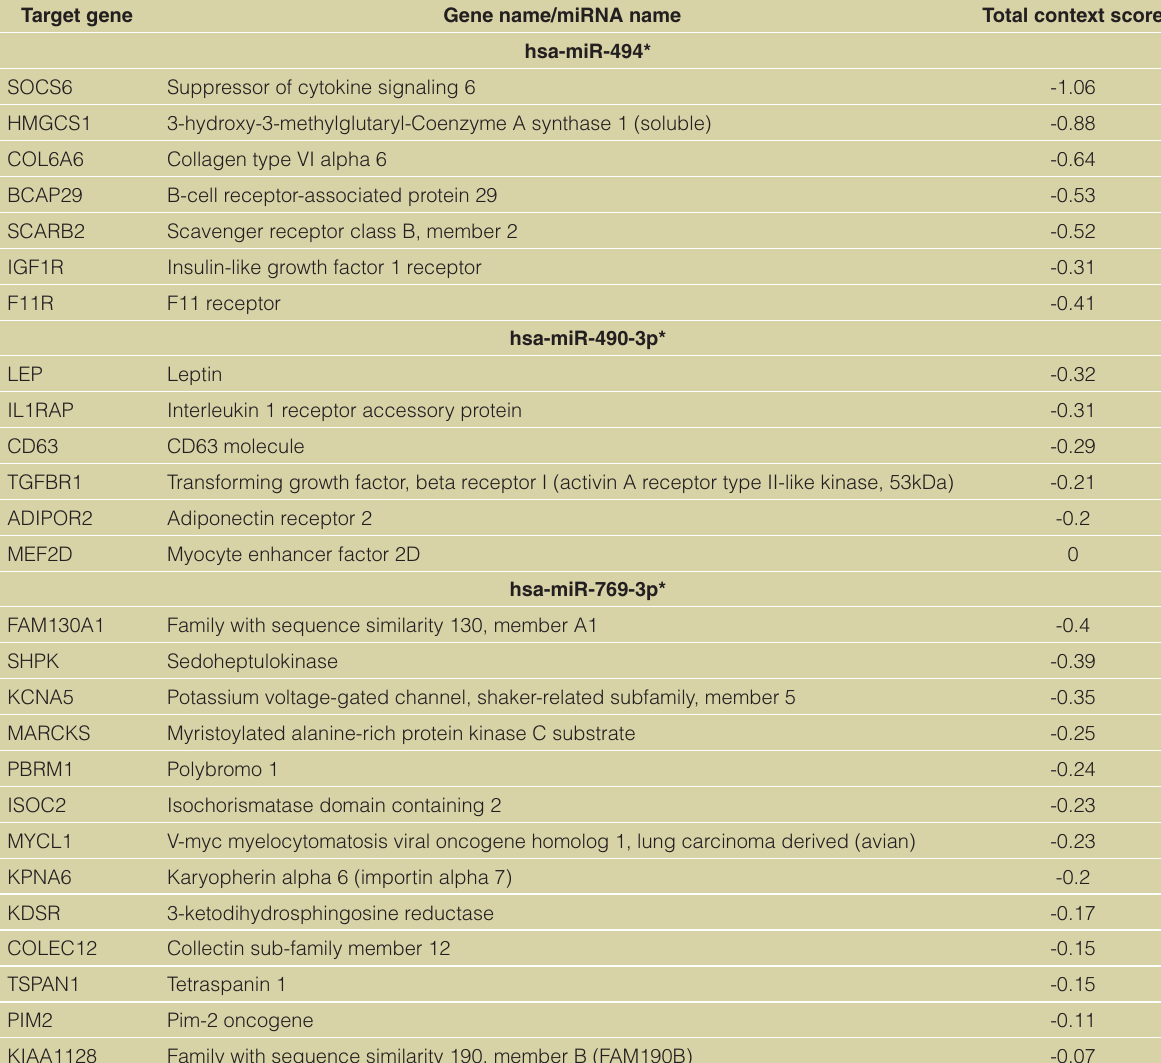
Table 5. MiRNA predictions for target genes associated with significant coronary disease using TARGETSCAN. Individual miRNAs target genes identified as significantly different between patients with and without significant coronary disease were selecting using the context score, a sum of; site-type contribution, 3’ pairing contribution, local AU contribution, and position contribution. The lowest scores show highest